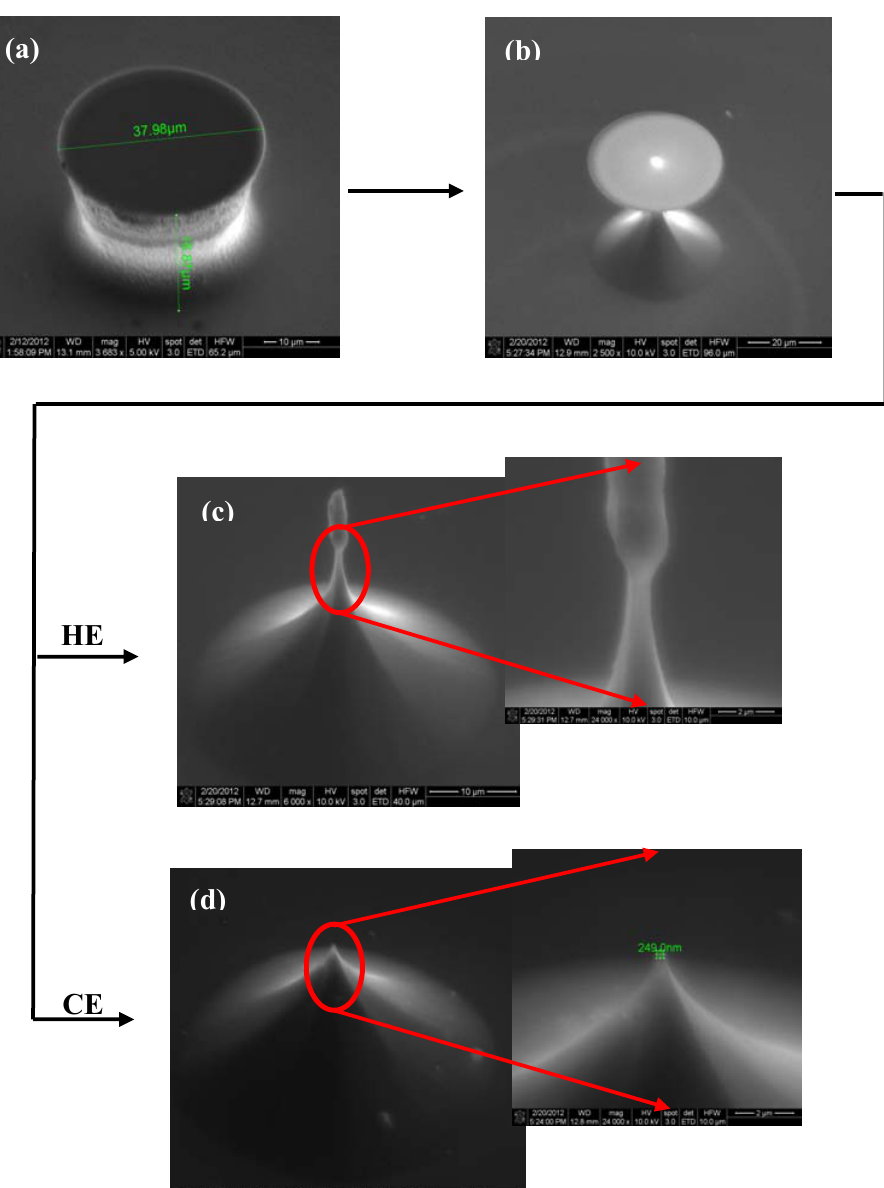
Figure 3. SEM images of an electrode in different stages of substrate dry and isotropic wet